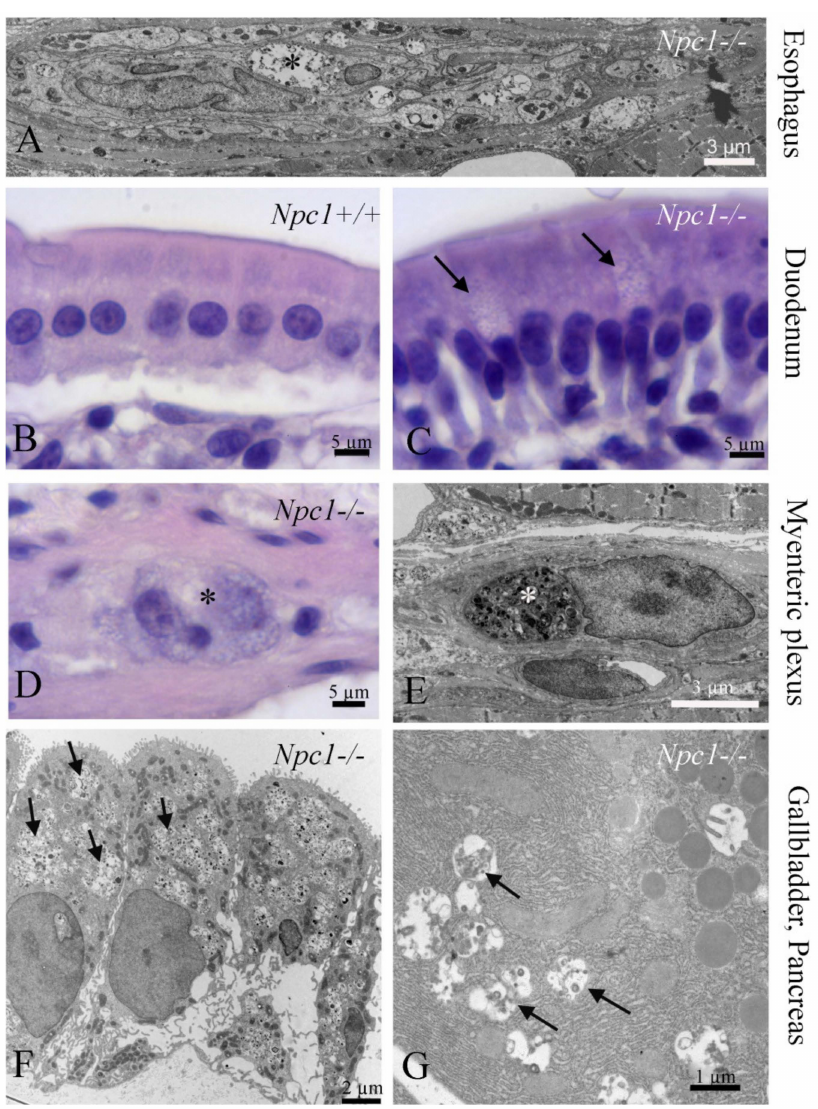
Figure 3. Phenotypes of NPC1 in the gastrointestinal tract. ( A ) Myenteric plexus in the esophagus with myelin-like inclusions in glia cells (asterisk). ( B ) Normal duodenal enterocytes in Npc1 +/+ , and ( C ) pathological cells (arrows) in an Npc1 − / − mouse. ( D , E ) Autophagosomes in ganglion cells of the myenteric plexus in the duodenum. ( F ) LE / LY storage in epithelium of the gallbladder and ( G ), in acinar cells of the exocrine